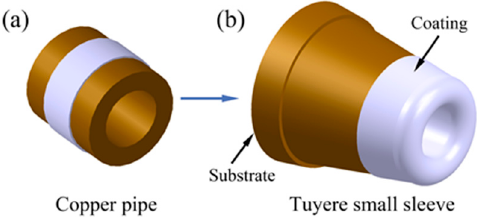
Figure 1. Development sequence of plasma cladding wear-resistant coating on copper substrates with different shapes.